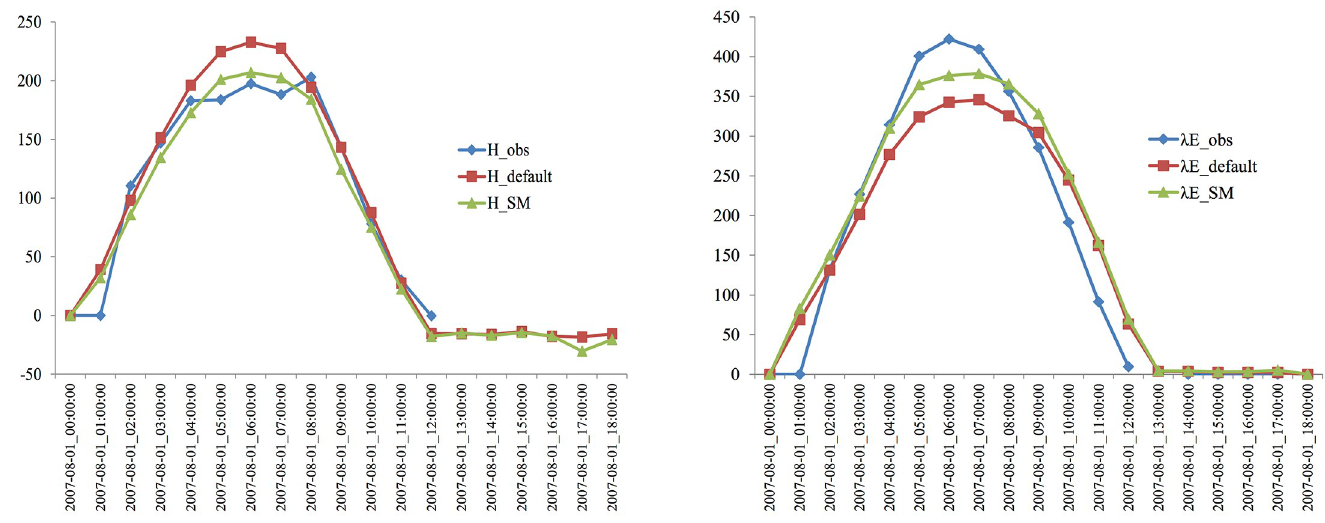
Fig 4. Comparisons of the sensible and latent heat fluxes obtained from the in situ data, default model configuration and assimilation experiment (units: Wm-2).